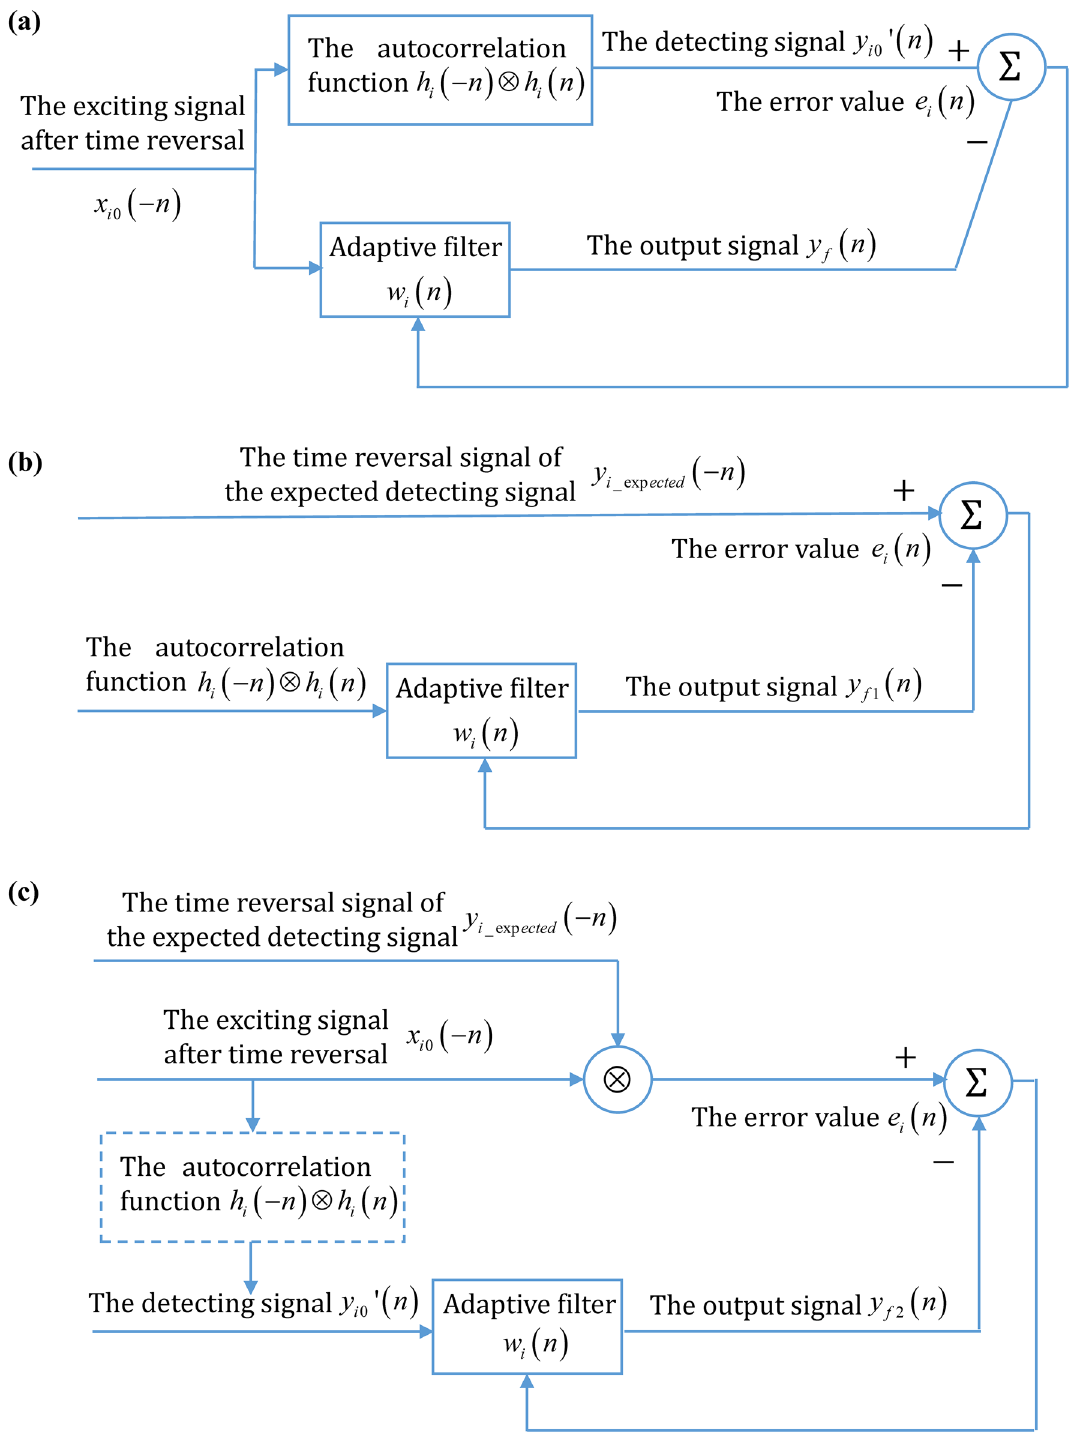
Figure 6. The adaptive filtering deconvolution operation. ( a ) The flow diagram to calculate the autocorrelation function of the detecting system’s impulse response. ( b ) The flow diagram to calculate the exciting signal corresponding to the expected detecting signal. ( c ) The process diagram after the